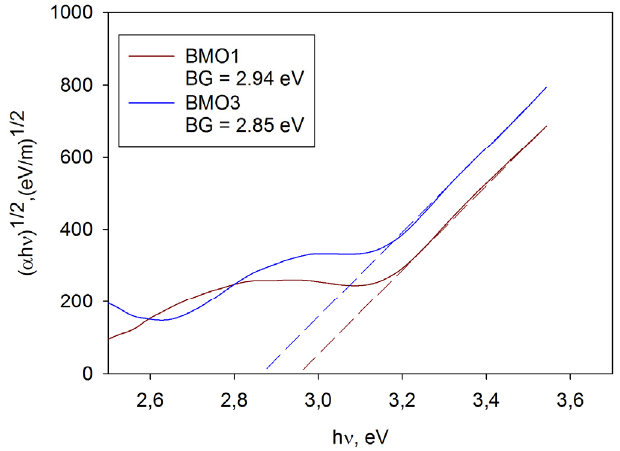
Figure 6. Examples of band gap calculation for coatings BMO1 and BMO3.